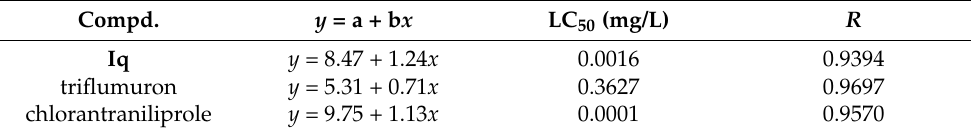
Table 2. LC 50 values of compounds Iq , triflumuron and chlorantraniliprole against the diamondback moth ( Plutella xylostella